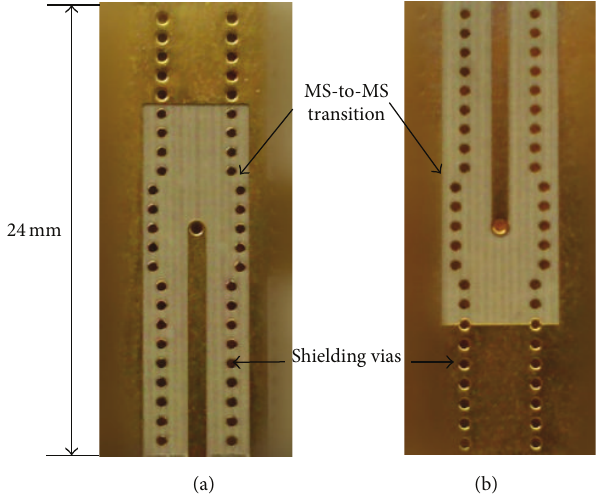
Figure 12: Fabricated circuit of the MS-to-MS transition. (a) Top view; (b) bottom view.